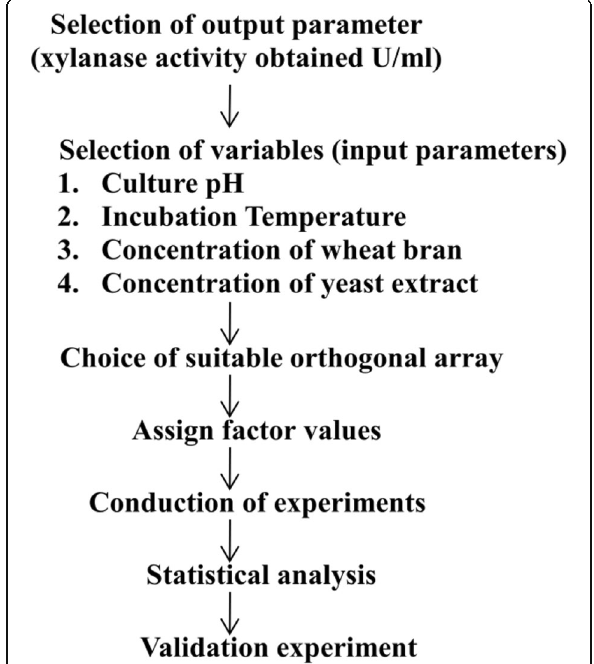
Fig. 1 Steps in statistical optimization using the Taguchi